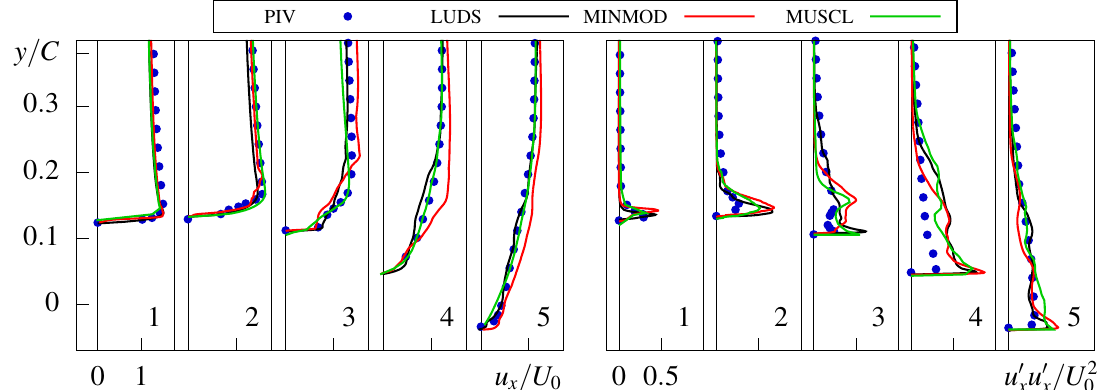
Figure 13. Comparison of experimental and numerical profiles of the streamwise component of conditionally averaged velocity and its fluctuations for regime I with ˜ α th = 0.25 based on Schnerr–Sauer